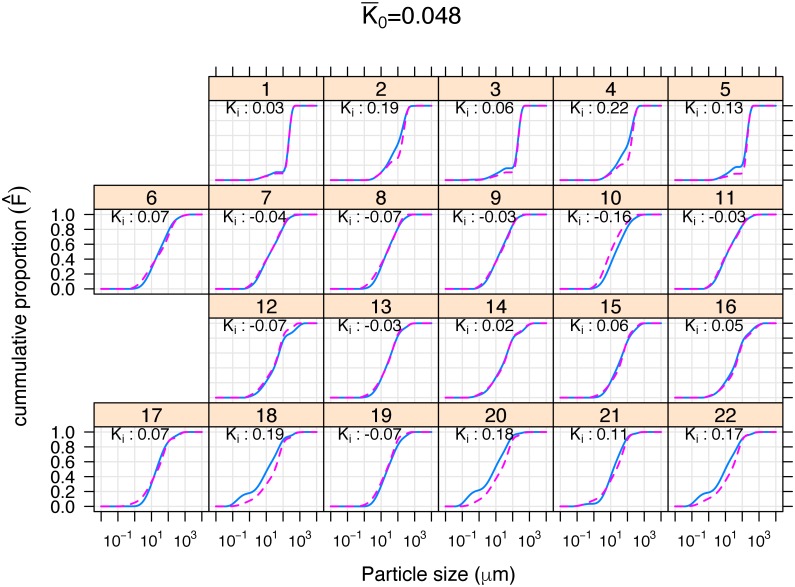
Plot of laser diffraction method cumulative particle size curves with the calculated K statistic.Plots are labelled with the sample ID (see Table 1), 1–5, Podosol; 6–11, Dermosol; 12–16, Chromosol; 17–22, Vertosol. Columns are alternating Topsoil/Subsoil. No pretreatment (NP) solid blue line; with pretreatment (P) dashed red line.